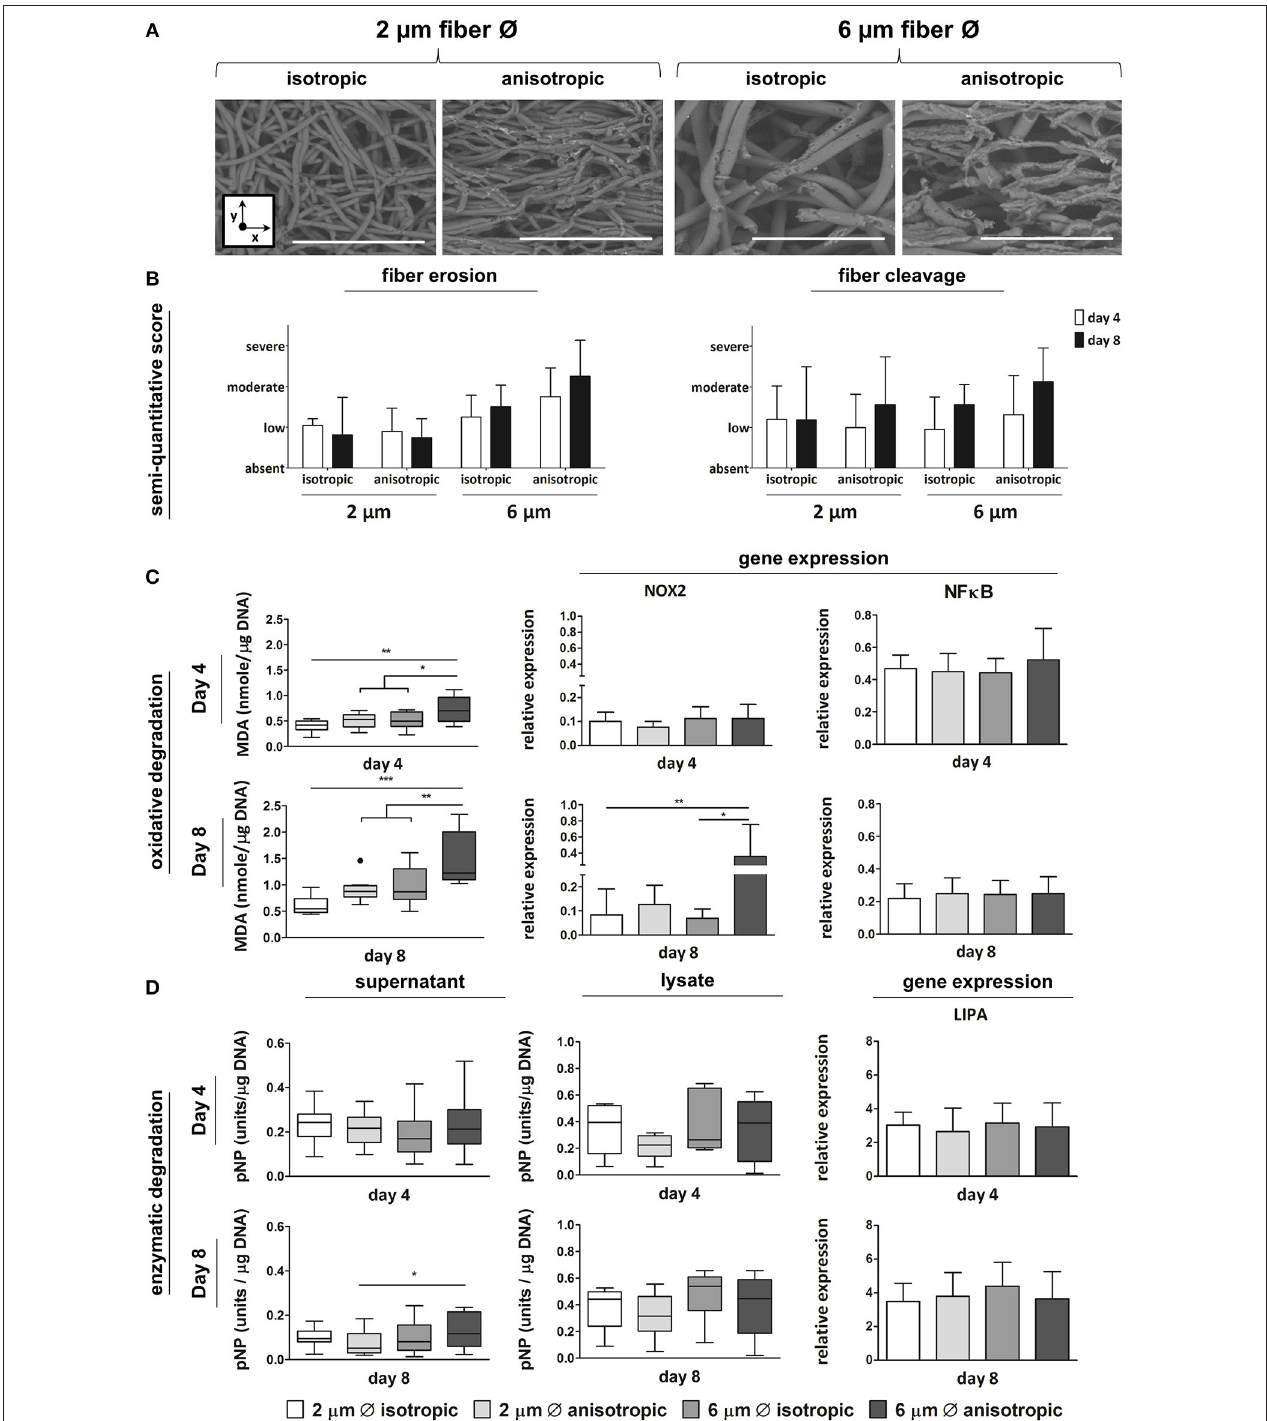
FIGURE 4 | Macrophage-driven biomaterial degradation. Representative SEM images of decellularized scaffolds at day 8. Scale bars, 40 µ m; x = circumferential direction of the electrospinning mandrel; y = axial direction of the electrospinning mandrel (A) . Semi-quantitative scoring of fiber erosion and cleavage seen in each scaffold type in time (B) . Oxidative degradation of the different scaffold microarchitectures in terms of malondialdehyde (MDA) presence and expression of the oxidative genes NOX-2 and NFkB (compared to CYC-1) at day 4 (top row) and day 8 (bottom row) (C) . Enzymatic degradation of the synthetic scaffolds investigated via esterase assays on both cell supernatant and lysate (1 unit = 1 nmol pNP released from pNPB per minute), and gene expression (compared to CYC-1) of LIPA at both day 4 (top row) and day 8 (bottom row) (D) . A dot represents a statistical outlier. * p < 0.05; ** p < 0.01; *** p < 0.001, N ≥ 6/group/time point.